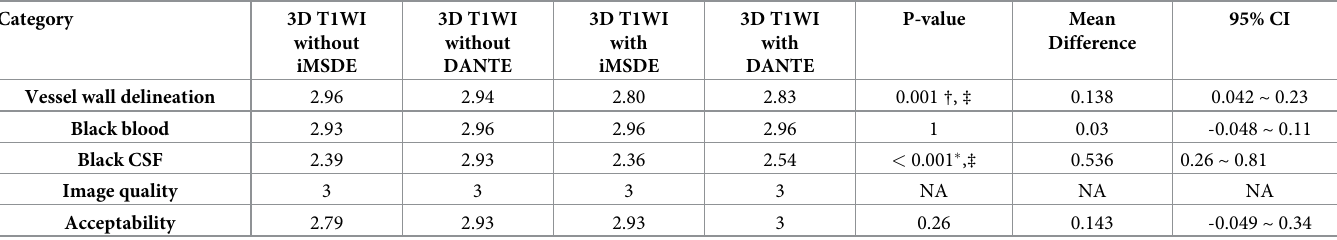
Table 1. Comparisons of visual scoring system results between 3D TSE T1WI with or without iMSDE and DANTE. Category